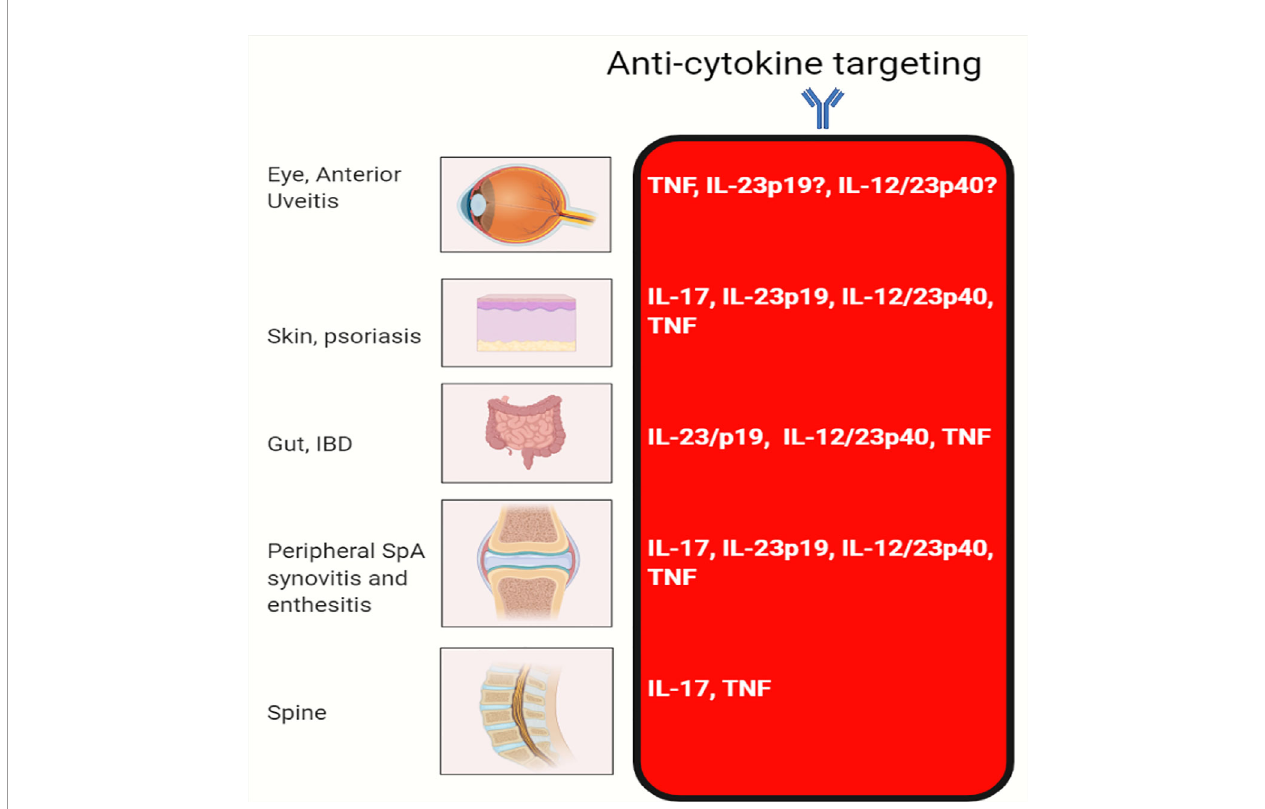
FIGURE 2 | Ef fi cacy of cytokine blocking in different organs. The classical MHC class II associated autoimmune diseases that are characterised by autoantibody production segregate in families and individuals and show a female preponderance. The SpA group of diseases do not show substantial sex differences, have MHC class 1 genetic associations, a lack of speci fi c con fi rmed disease associated autoantibodies and disease localisation to sites of injury or physical stressing. It is into this mix that genetics and experimental immunology have fi rmly con fi rmed the key role for the IL-23 pathway. Given that IL-23 regulates both IL-22 and IL-17, we believe that in addition to immunity including anti-fungal immunity via IL-17 regulation that the IL-23 pathway fi ne tunes tissue repair at sites of injury and physical or chemical stressing as for example in the intestine. TNF-Fc fusion protein, etanercept does not work for IBD and generally not effective for anterior